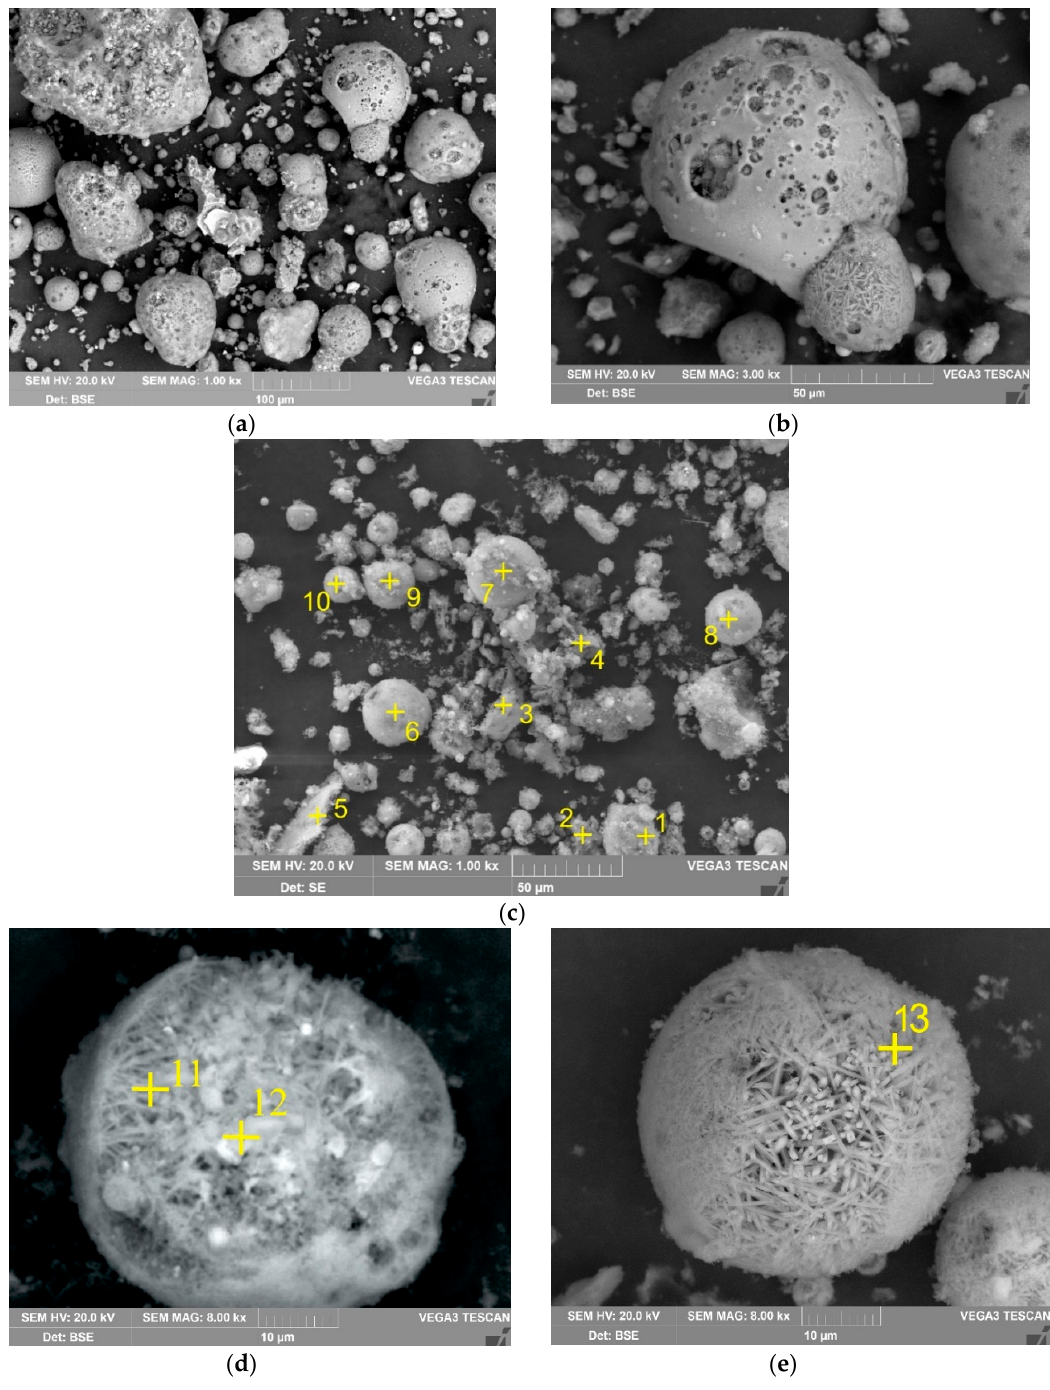
Figure 8. The SEM images of the solid residue at 1000 magnitude ( a ) and at 3000 magnitude ( b ); the SEM images with the EDX analysis at 1000 magnitude ( c ) and at 8000 magnitude ( d – e ) (yellow cross indicates place of SEM-EDX analysis; the elemental compositions are shown in Table 6).